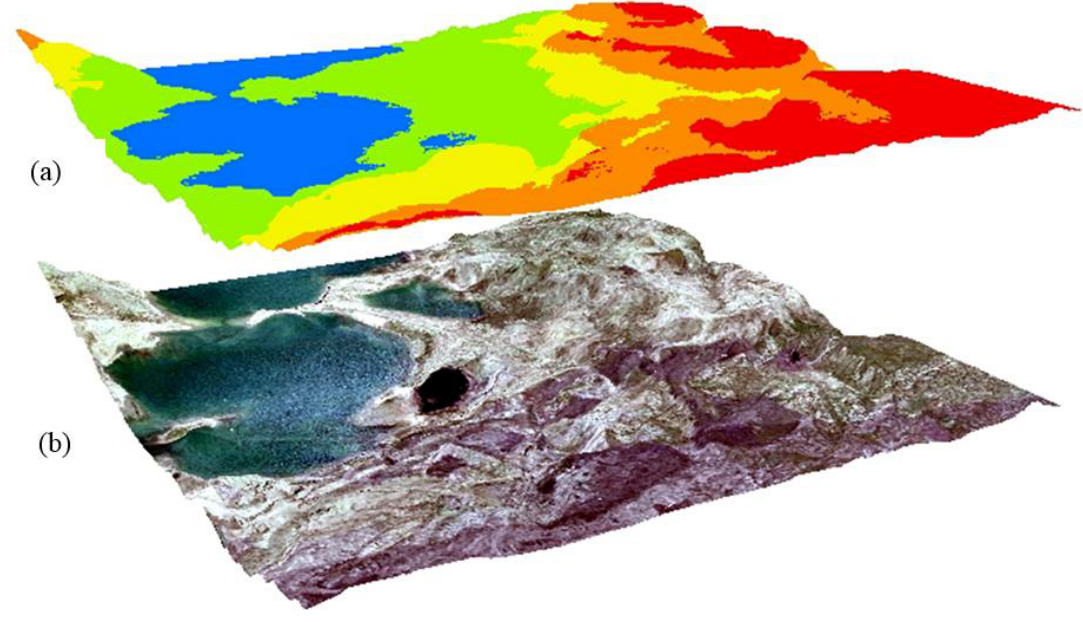
Figure 3. ( a ) LIDAR DEM; ( b ) Orthophoto.